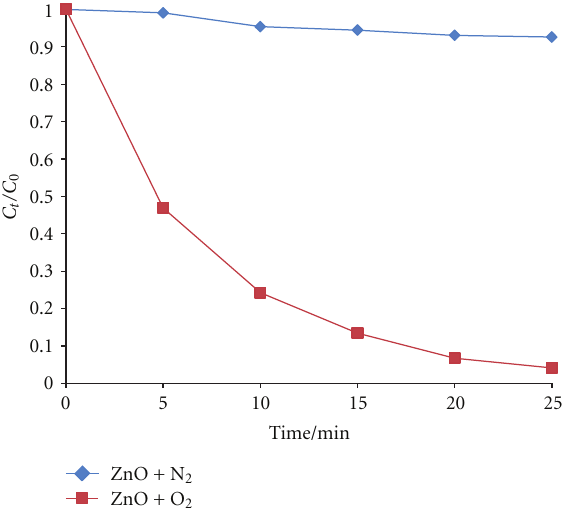
Figure 7: E ff ect of type of gas on photodecolorization of cobalamin by ZnO.